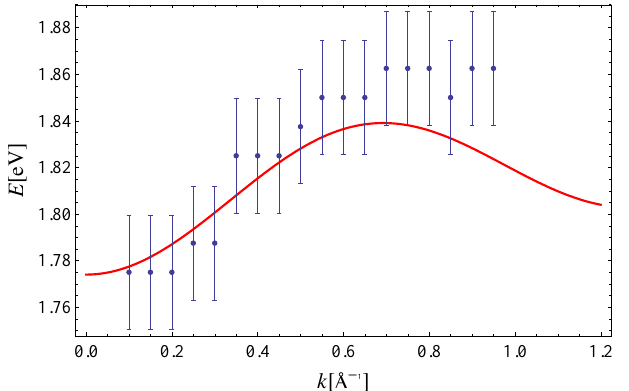
= 5.7 meV and I x = 23.4 meV. 3 1